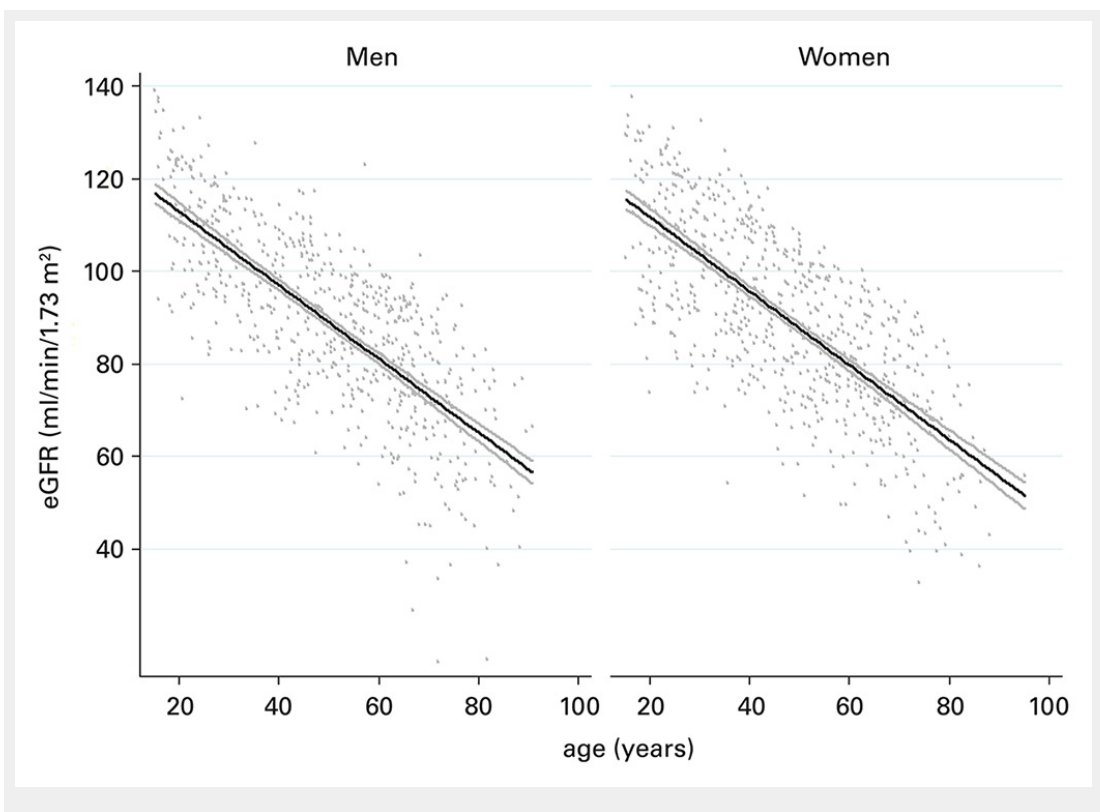
Figure 3 Relationship between renal function (eGFR by CKD-EPI equation) and age in the Swiss population. Bold lines represent the unadjusted linear regression estimation, gray lines 95% confidence interval. Decline slope (SE): –0.79 (0.03) ml/min/ 1.73 m 2 /year for men, –0.80 (0.03) ml/min/1.73 m 2 /year for women CKD-EPI = Chronic Kidney Disease Epidemiological